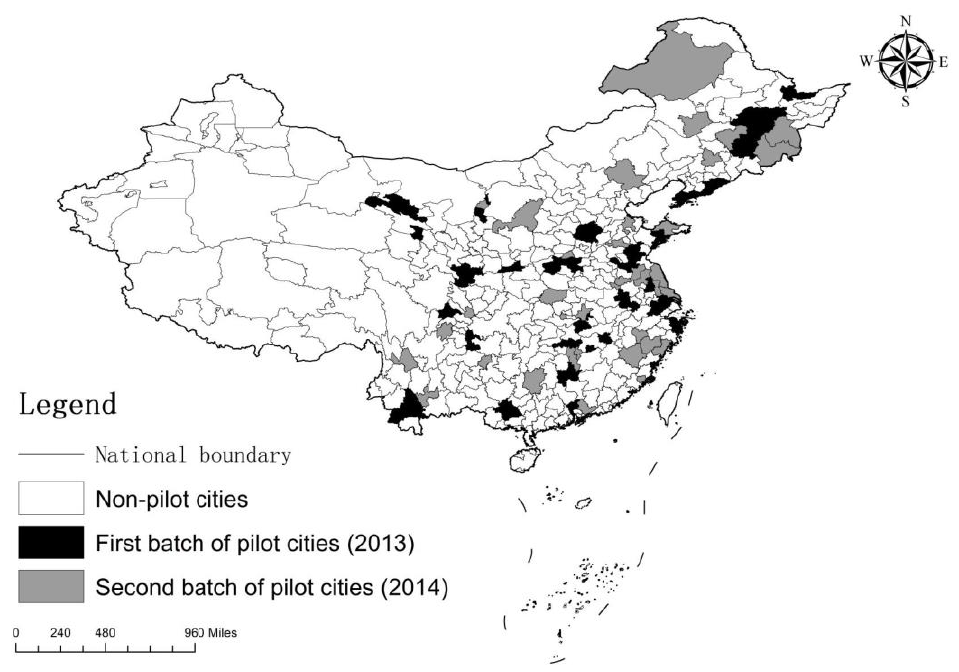
Figure 1. Spatial distributions of the two batches of water civilization construction pilot cities in China. Table 1. Lists of water ecological civilization pilot cities.